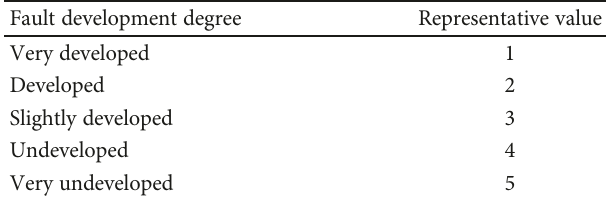
Table 4: Fault development degree.